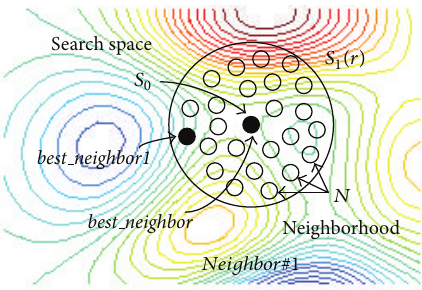
Figure 14: Random 𝑆 0 in search space. Figure 15: Neighborhood around 𝑆 0 .